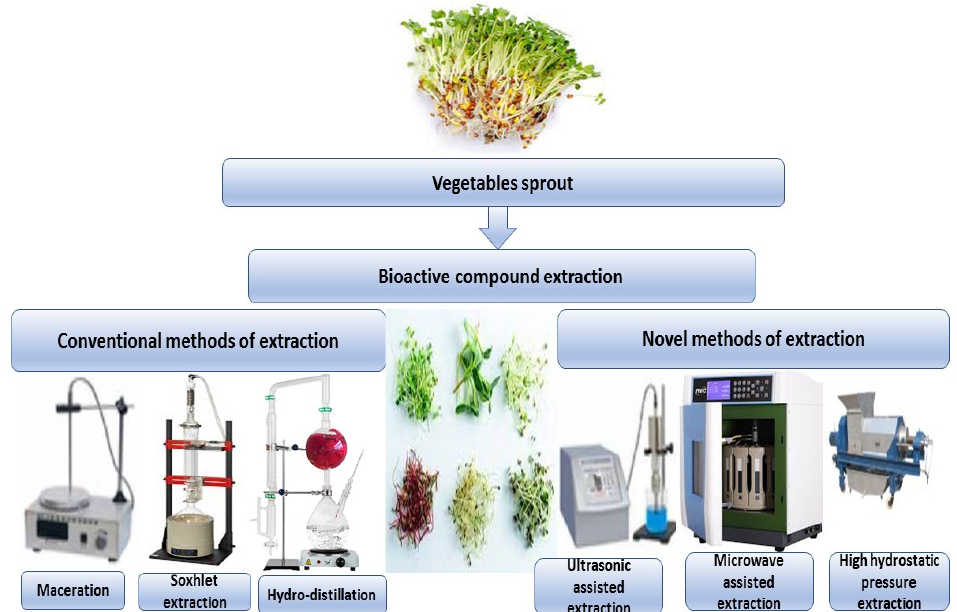
Figure 2. Conventional and new techniques can be used to extract bioactive compounds from dif- ferent types of vegetable